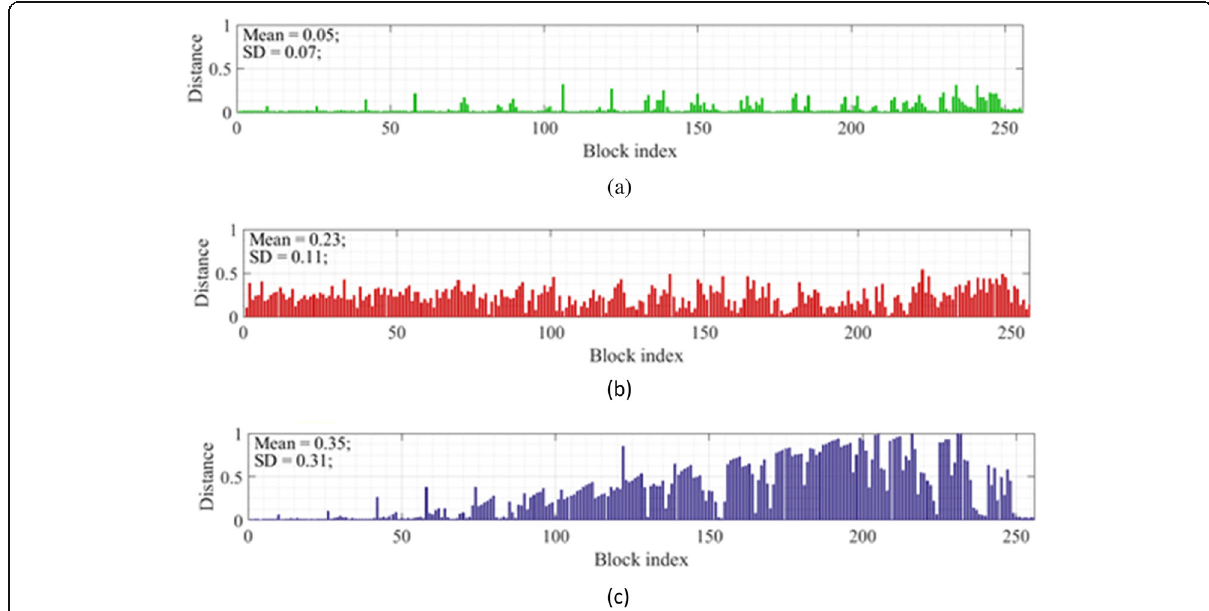
Fig. 6 a The distance between local blocks of the cover and the secret image for the complex measure, ( b ) the maximum number of most similar blocks, and ( c ) random selection used to choose the cover